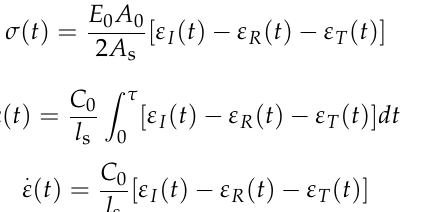
Figure 5. Typical voltage-time waveform.